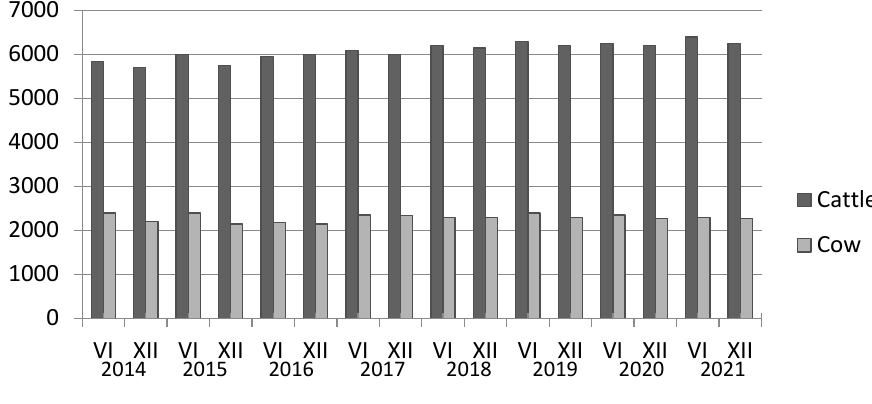
Figure 2. Cattle population (in thousands) including cows 2014–2021 in Poland [69]. Figure 2 . Cattle population (in thousands) including cows 2014–2021 in Poland [69].